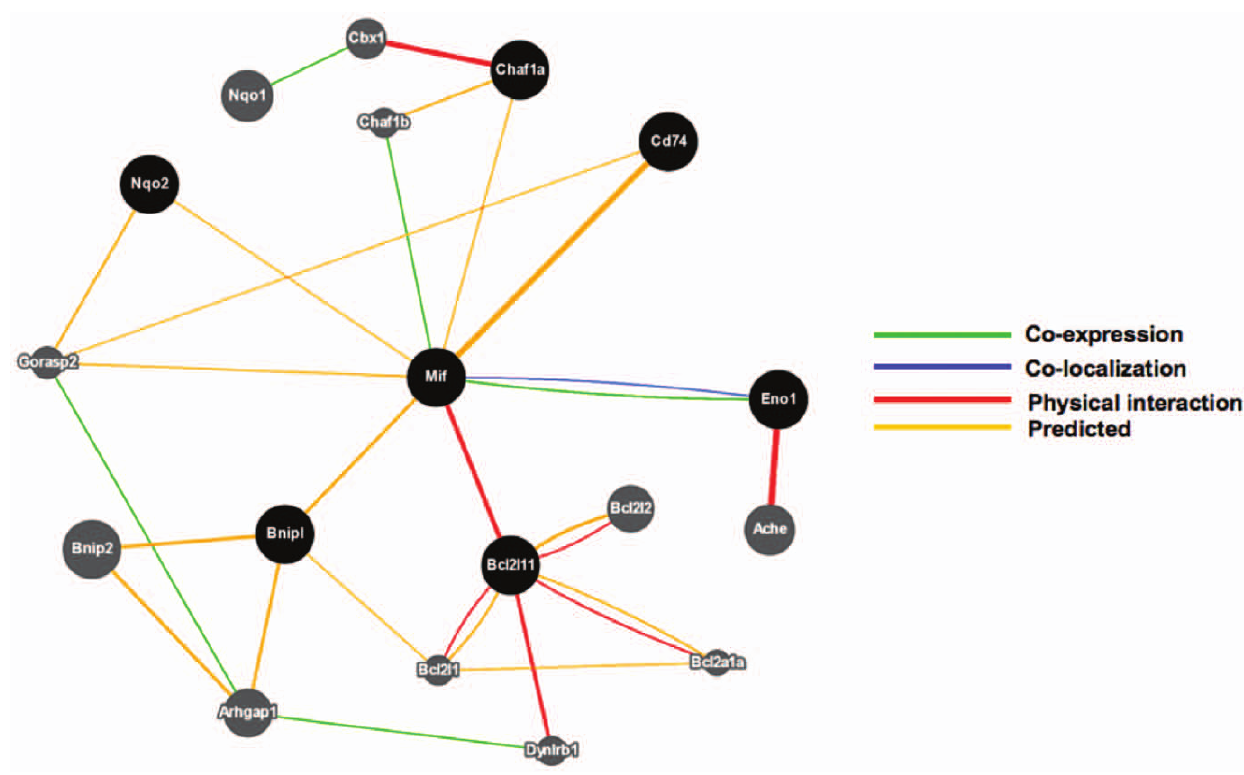
Figure 7. GeneMANIA fast gene function predictions of relationship between Mif other interacting genes. Mif has been predicted to interact with genes including that encodes its canonical receptor, Cd74 (indicated by orange lines). Mif has been shown to physically interact with pro-apoptotic genes such as Bnipl and Bcl2l11 , which in turn interact with Bnip2 , Bcl2l1 , Bcl2a1a and Bcl2l2 .